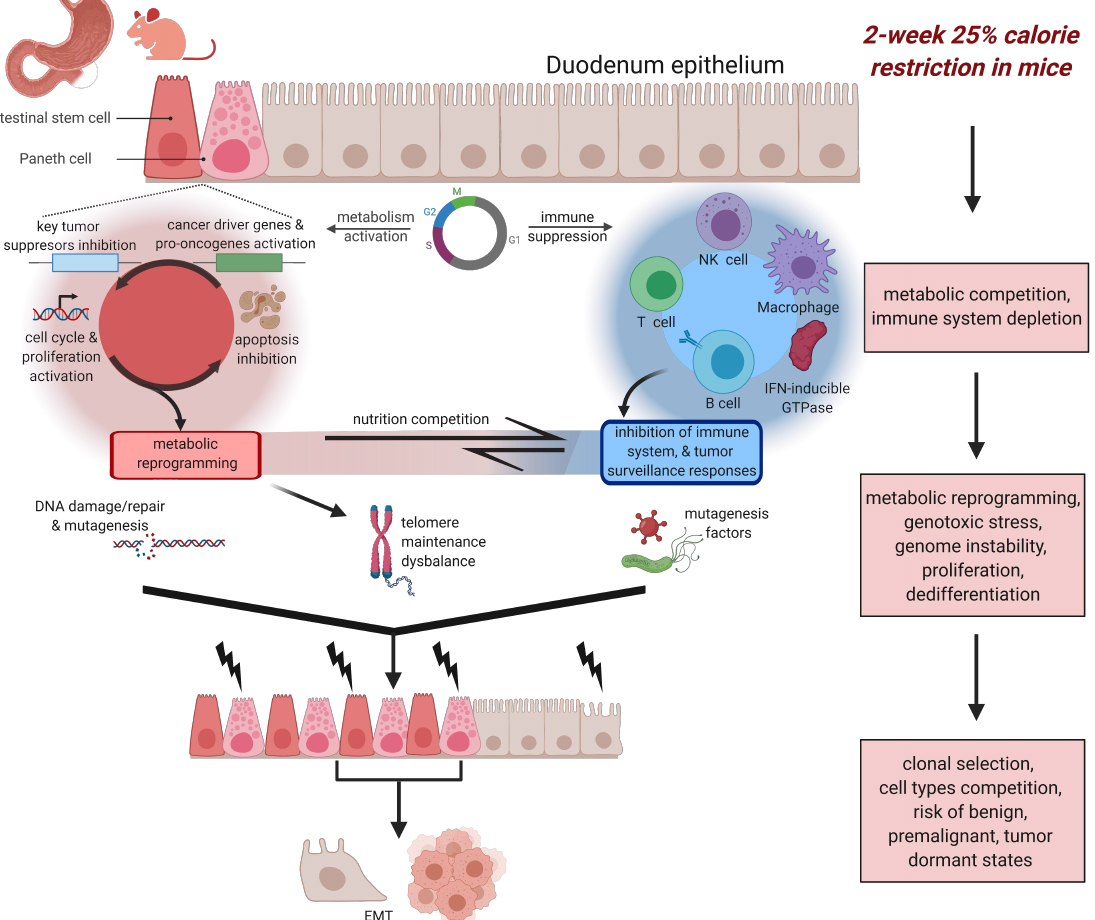
Figure 10. CR cellular disbalance models through immune and autophagy suppression. CR-induced metabolic repro- gramming and immune suppression. DEGs and pathways analyses strongly support our hypothesis that CR dramatically changes the epithelial versus immune cells relationships. Functional interactions modulating the homeostasis cooperation between cell types may increase malignancy risk. Morphologically, mucosa enterocyte differentiation and their cell type density depend on the cell position along both the vertical axis (crypt-villus) and horizontal axis (proximal to distal) of the GI tract. At steady-state in normal conditions (homeostasis) of mucosa tissue, the cell types at differentiation states are position-dependent and relationships between cell types remain balanced. Our results suggest that CR induces a hypocellular and multiple cell-types disbalance by stimulation of cell proliferation and autonomation of this process. Our model suggests that CR response leads to metabolic activation, inducing cell cycle genes and proliferation of epithelial stem cells. CR reduces the total mass of epithelial cells (vertical axis) [21], autophagy, apoptosis mechanisms, and telomere stability. Immune cell populations including progenitors and effector cells are globally reduced, suggesting increased pathogen susceptibility. If the processes controlling DNA and RNA damage induced by chemical carcinogens become dysregulated, it increases the risk of transformation and uncontrolled proliferation of abnormal stem-like